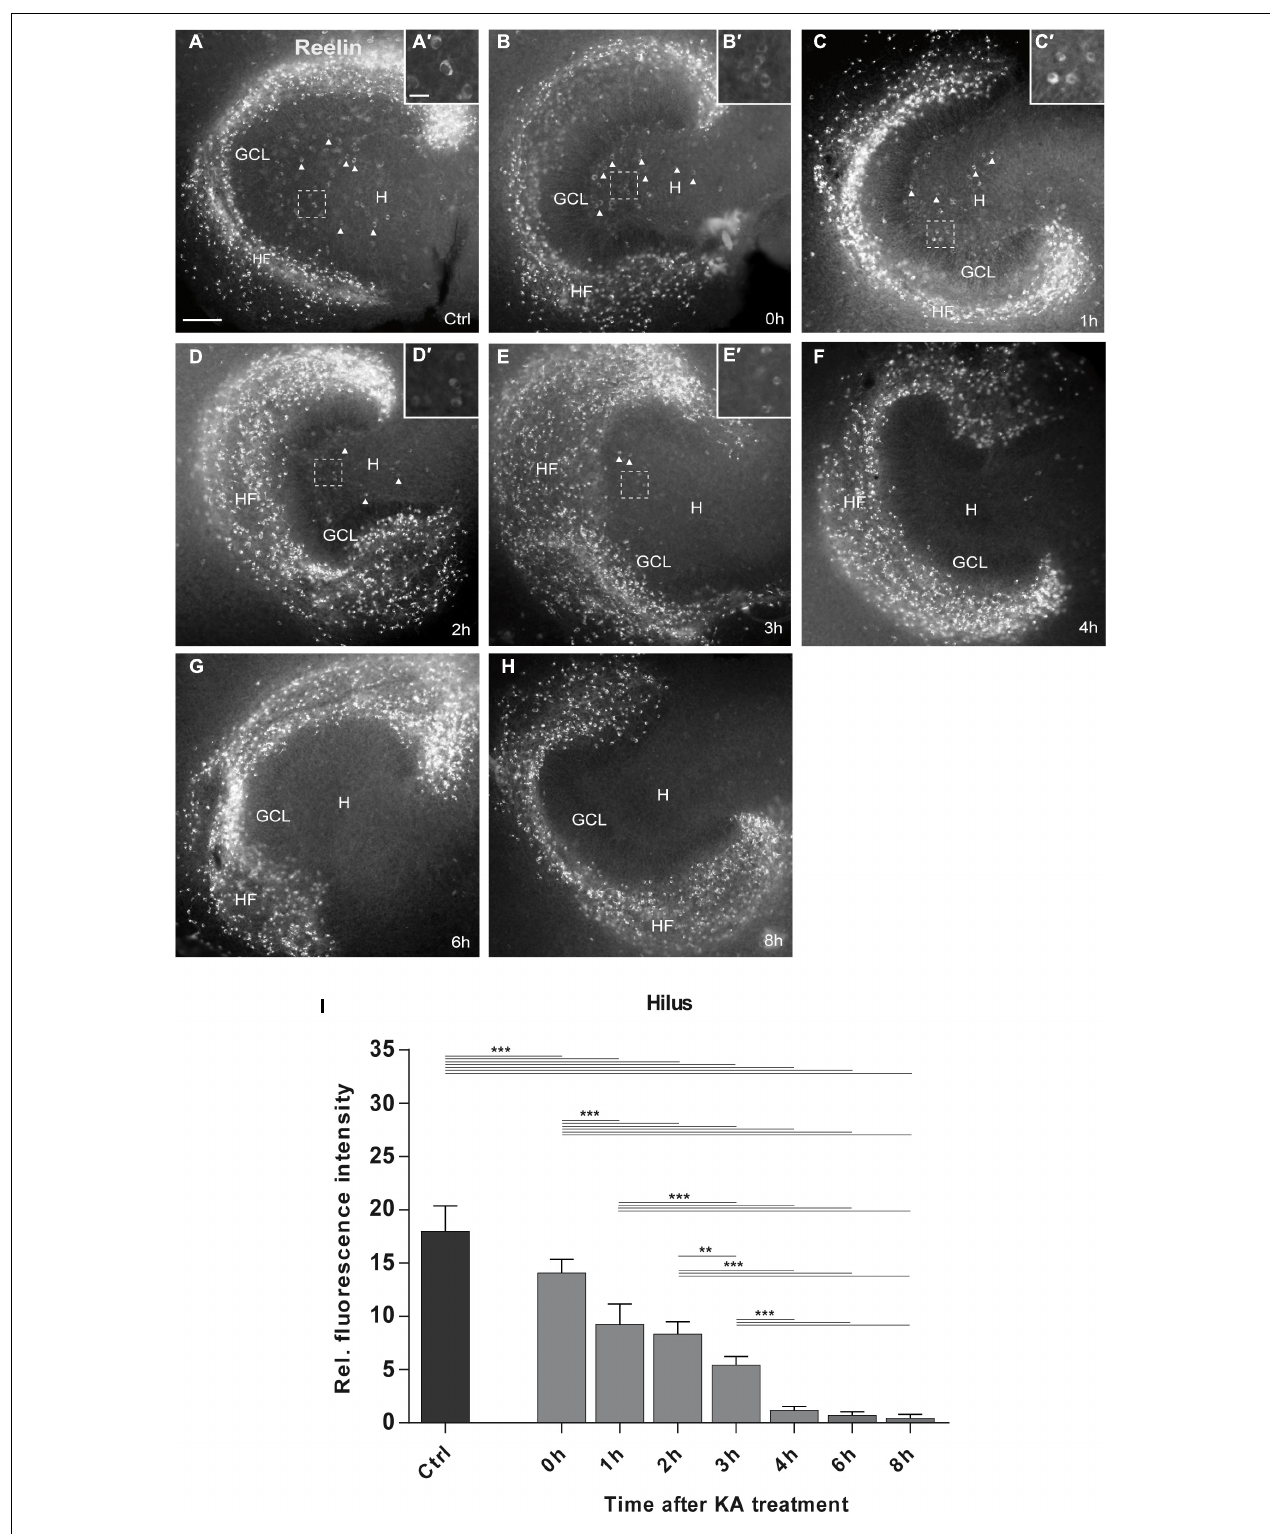
FIGURE 2 | Time course of KA-induced loss of Reelin-expressing neurons in the hilus. Representative images of whole OHSC immunolabeled for Reelin are shown. Small insets show high magnification of Reelin-expressing interneurons in the area of the hilus indicated by the dashed white frame (A’–E’) . (A) In control slices